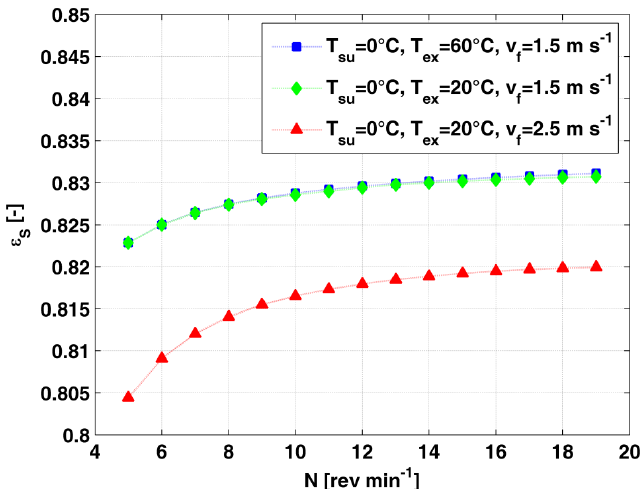
Figure 5. Effect of revolution speed, inlet temperature and face velocity on sensible effectiveness ( a c = b c = 2 mm, s = 0.06 mm, L = 0.2 m, X a,in = 3.0 g/kg).